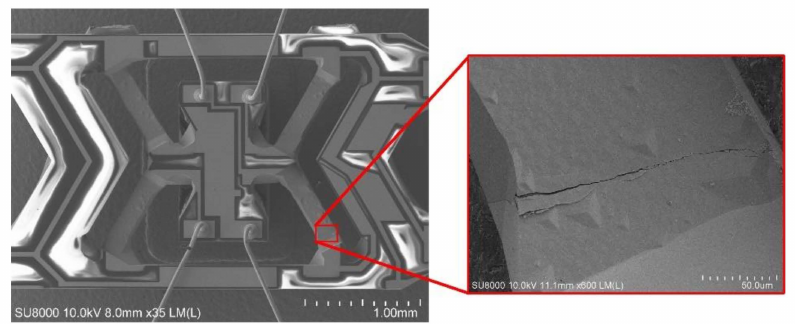
Figure 23. The broken V-shaped beam after the shock.